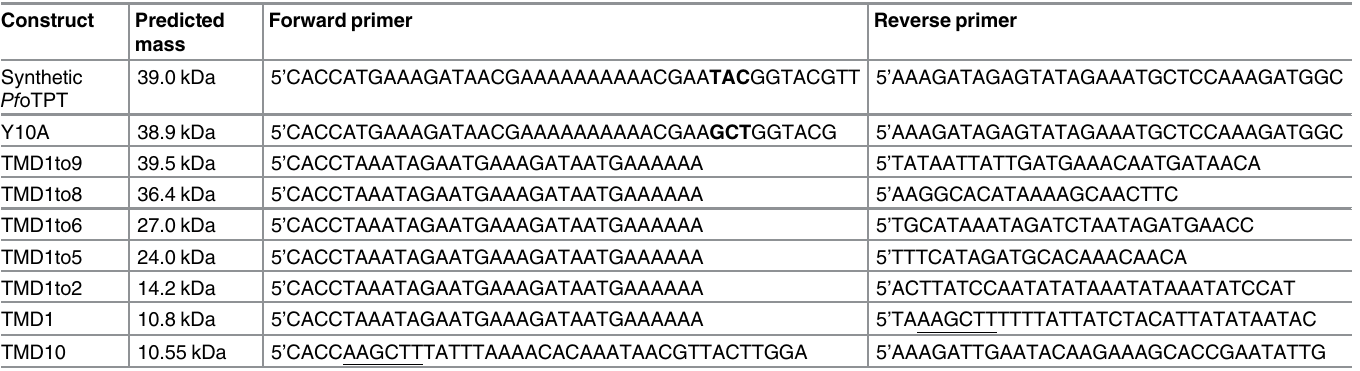
Table 1. Predicted masses and primer pairs for the Pf oTPT transfection constructs. The tyrosine (Y) codon in synthetic Pf oTPT and the alanine (A) codon in Y10A are in bold. The predicted mass given for TMD10 is for the entire TMD1+TMD10 fusion protein. The Hind III cloning sites are underlined. A Hin- d III site is naturally found within TMD1 and one was added to the TMD10 forward